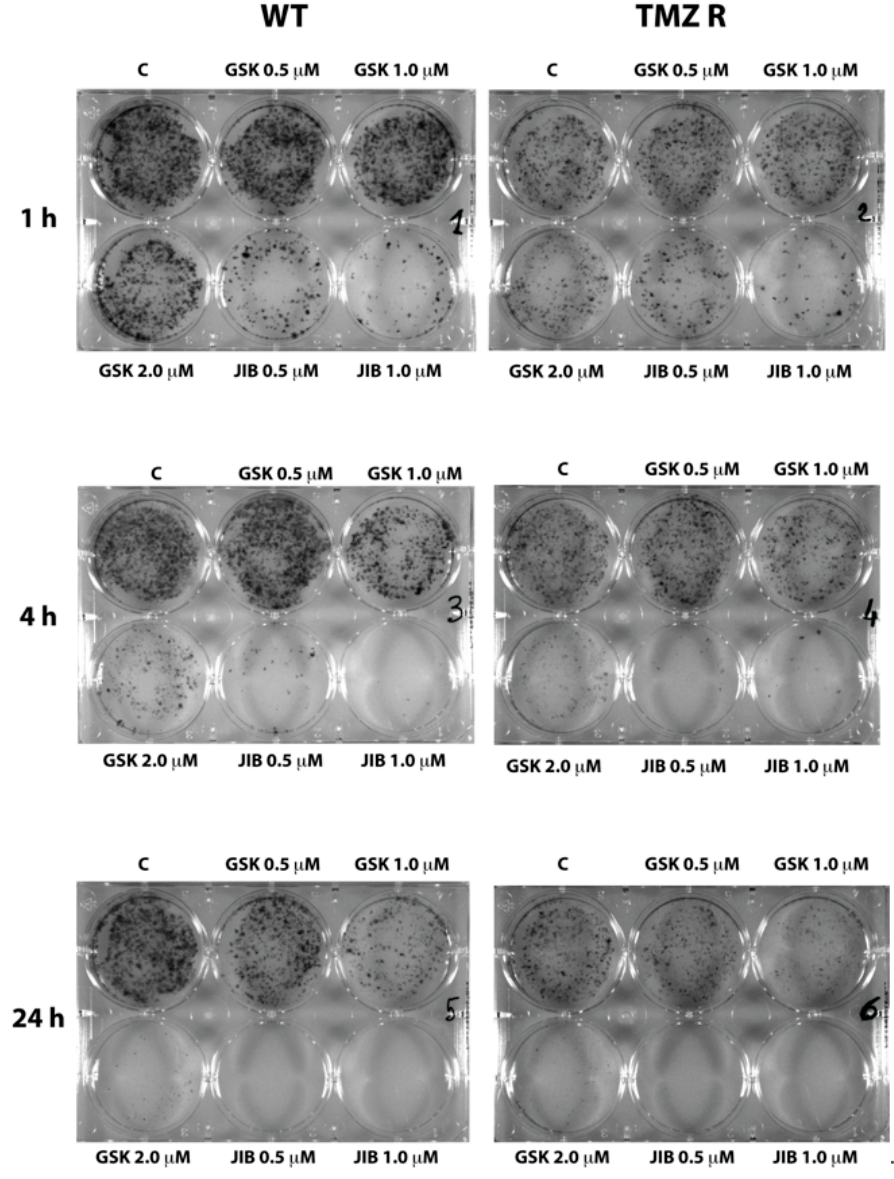
Figure 5. Inhibition of clonogenic activity of GSK J4 and JIB 04 on GBM3 cells. Native and TMZ- resistant GBM3 cells were incubated with different concentrations of KDMi for 1, 4, and 24 h and plated. After 7–10 days, the cells were fixed on plate and stained. The stronger potency of JIB 04 compared to GSK J4 was evident even after 1 h of